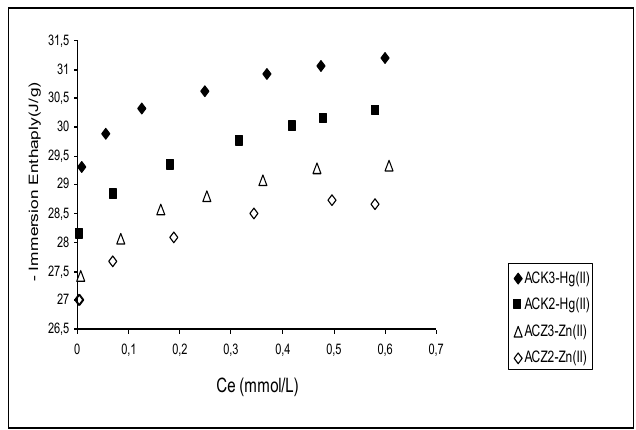
Figure 6. Immersion enthalpies of the Monocomponent and binary for Hg(II) and Zn(II) system onto